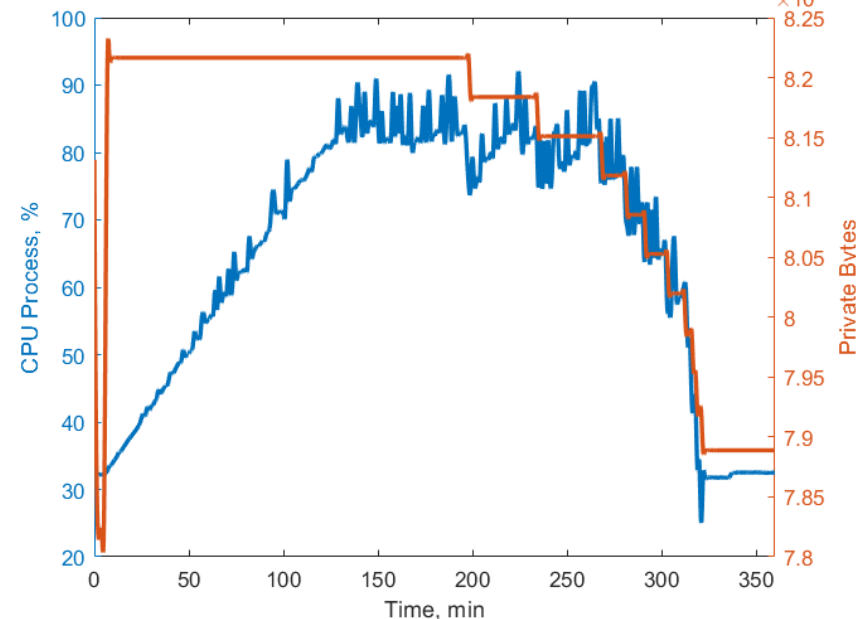
Figure 14. Computational performance, when 50 GB data stream was